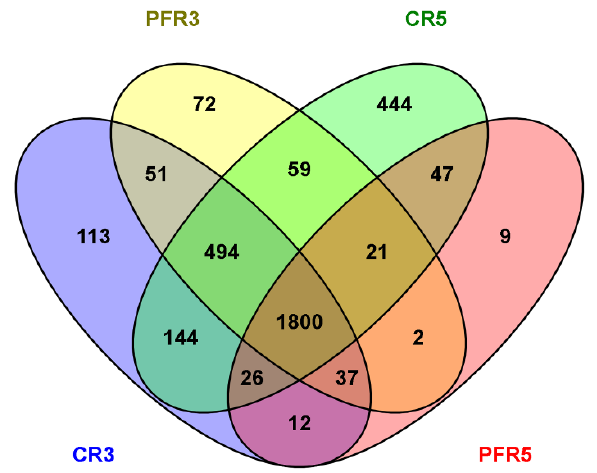
Figure 1. The Venn diagrams show the total number of 3331 OTUs (97% sequence identity) shared across different samples, as well as the number of OTUs present exclusively in calyx-end and peel tissues derived from bagged (i.e., CR5, PFR5) and unbagged (i.e., CR3 and PFR3) fruit.